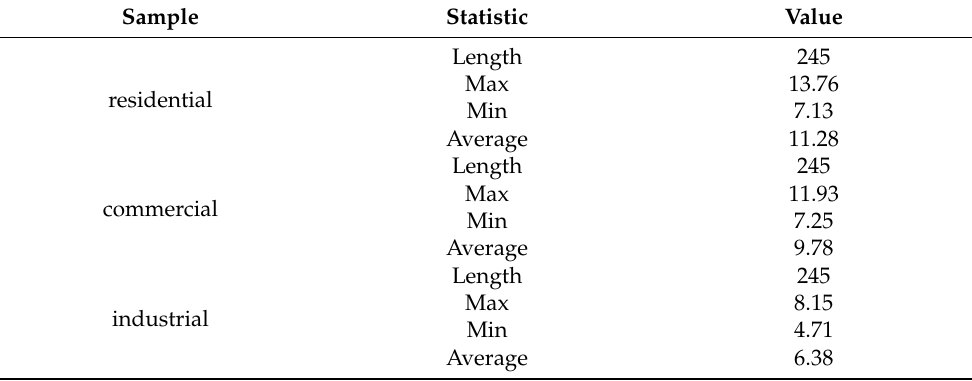
Table 1. Statistical description of three types of electricity price data samples in this